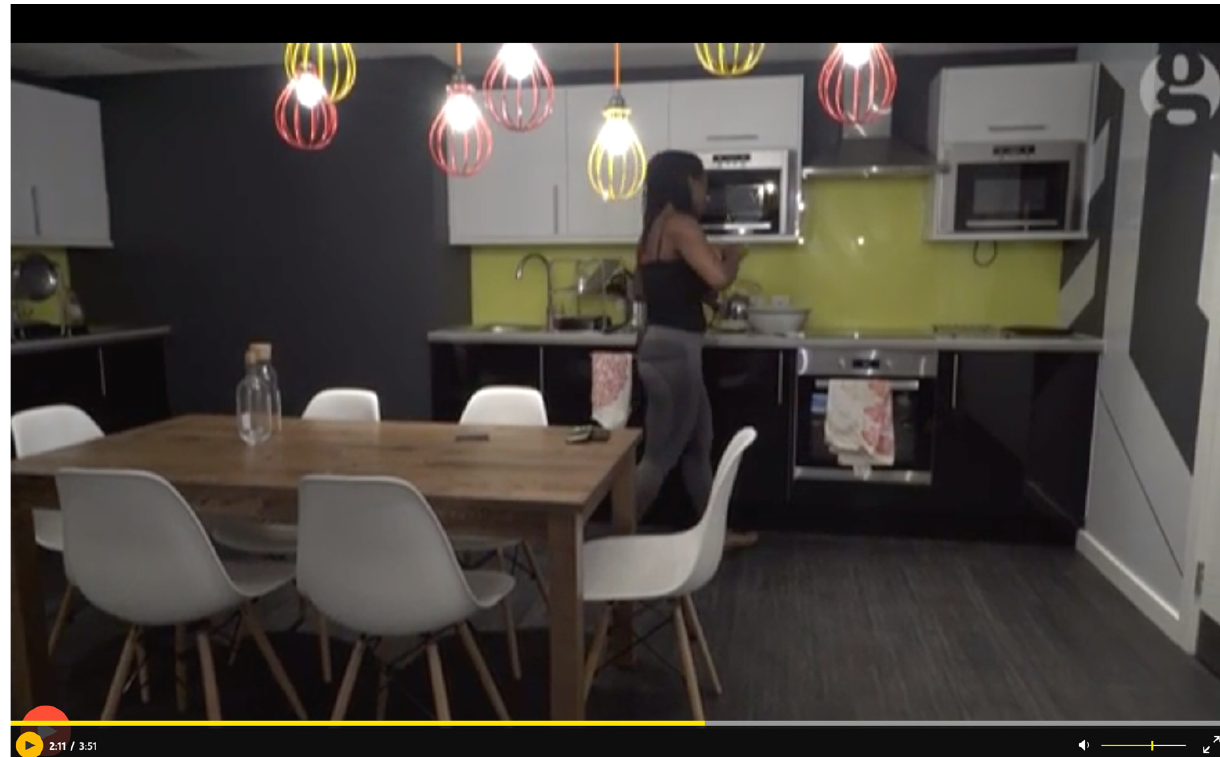
Figure 3. Collective kitchen of the Collective in London. Source: Still frame from Coldwell (2019).